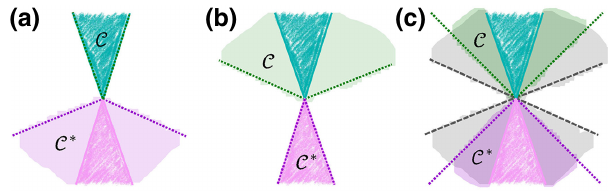
FIG. 2. A heuristic representation of the cones containing three possible GPTs sharing a subGPT. As described in